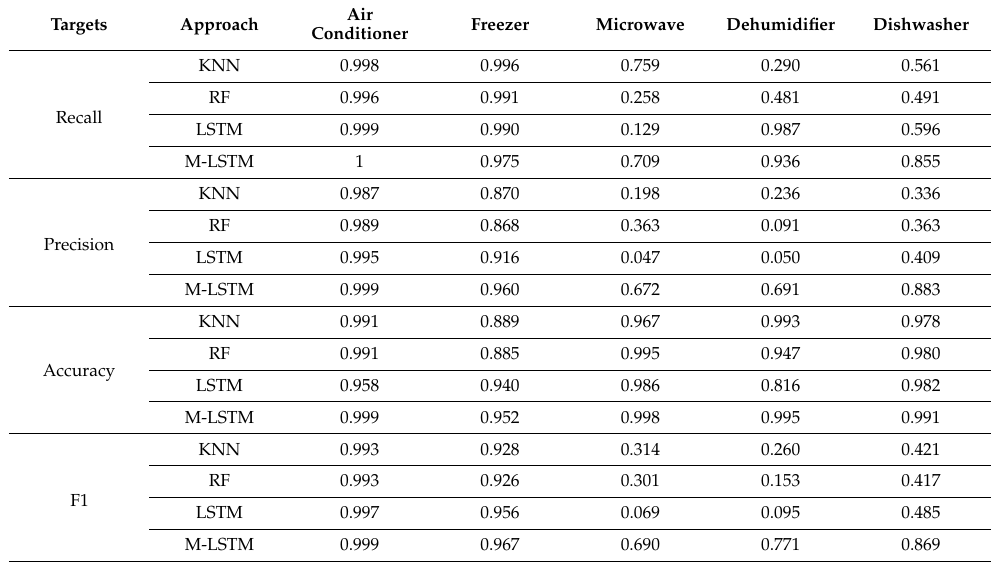
Table 2. Comparison of WikiEnergy 25 home load operational state indicators.